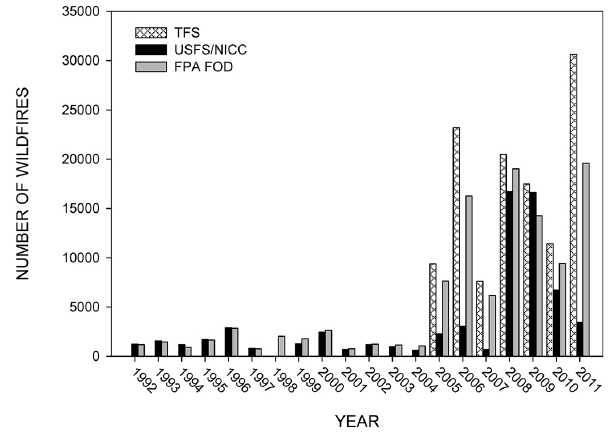
Figure 8. Number of wildfires in Texas, 1992–2011, estimated from reference sources, per Fig. 1, and from the FPA FOD. Esti- mates from the Texas A&M Forest Service (TFS), which are based on state and local reports only, are also included for 2005–2011. Viable non-federal data were available and included in the FPA FOD for all years. The FPA FOD and USFS / NICC estimates agree relatively well for the period 1992–2004, but those numbers are based only on federal records and records of fires responded to by the TFS, which is the state fire service. FPA FOD numbers in- crease during the period 2005–2011 due to the availability of viable data from local fire departments, acquired for 2005–2008 from the NASF database and for 2009–2011 from the TFS directly. The lo- cal numbers appear in the NICC estimates for 2008–2010 only, as county data. The agreement in estimates from the FPA FOD and USFS / NICC for 1992–2004 is clearly misleading if used as a proxy for completeness of the data set, because wildfires responded to solely by the local fire service are abundant in this state and are unaccounted for in those reference